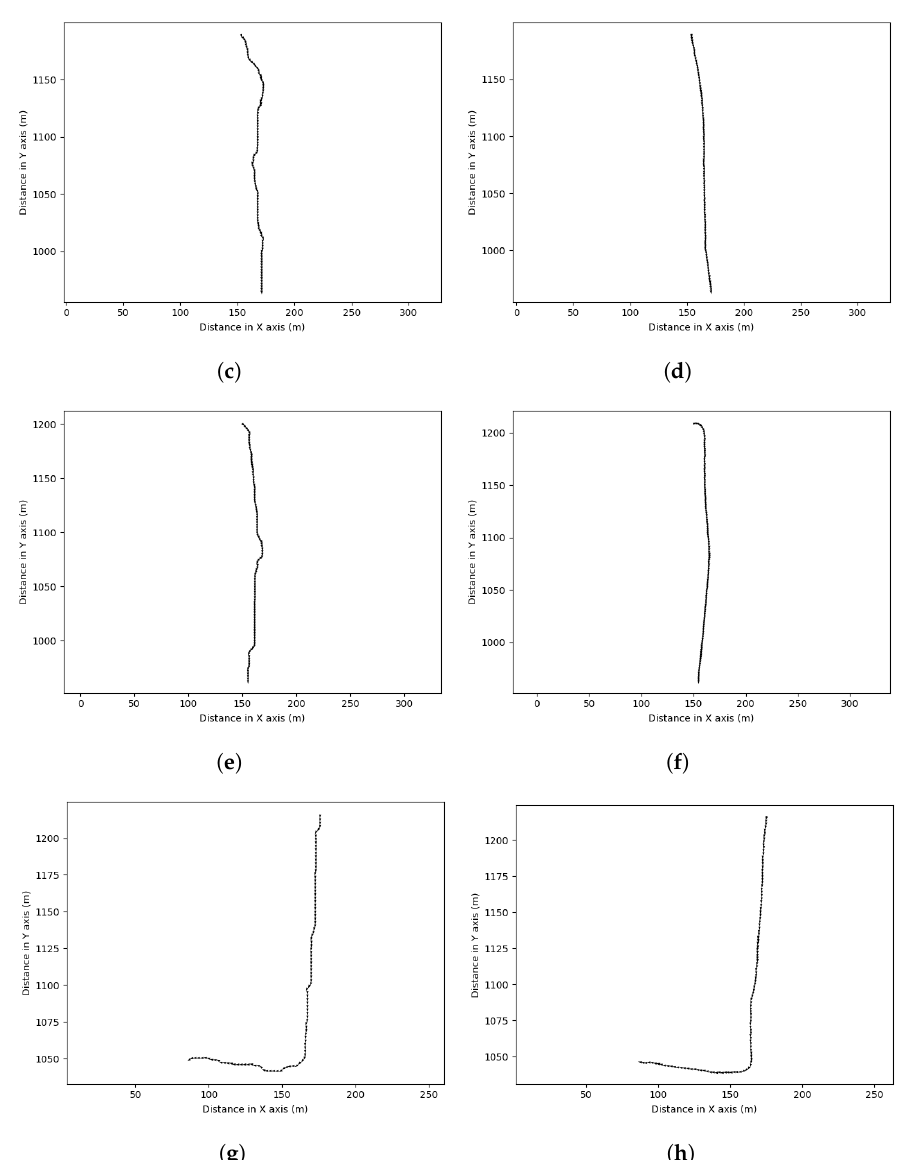
Figure 19. Examples of planned routes through various environments. Left ( a , c , e , g ) are shown the plans generated by A* planning through the traversability map. Right ( b , d , f , h ) are shown the plans generated by Medial Axis Transform (MAT) or “skeletonization” of the routes inferred by the model trained using traversability maps and route labels in conjunction. In all cases, the routes yielded by the A* approach do not exhibit the same level of “smoothness” as those shown right, which better reflect the kinematic capabilities of the